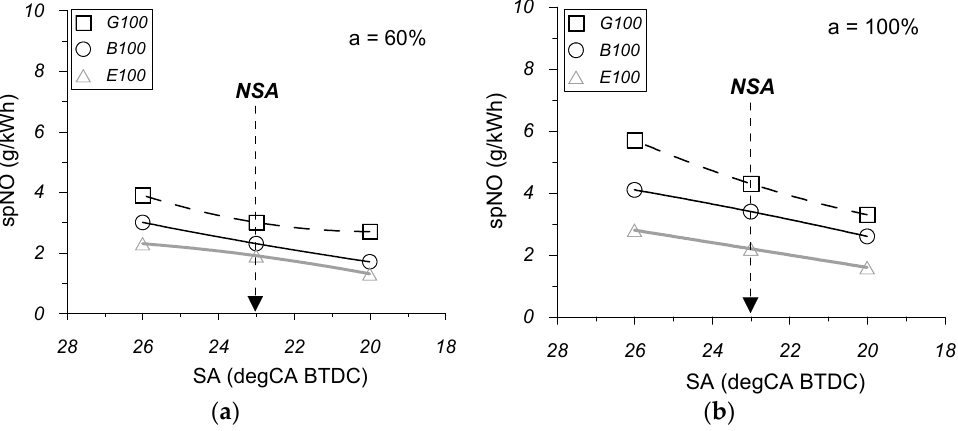
Figure 8. Variation of the calculated indicated specific NO concentration as a function of the spark advance for G100, B100 and E100 fuel operating modes, at 2400 rpm engine speed and 60% of full load ( a ); and 2400 rpm engine speed and 100% of full load ( b ).